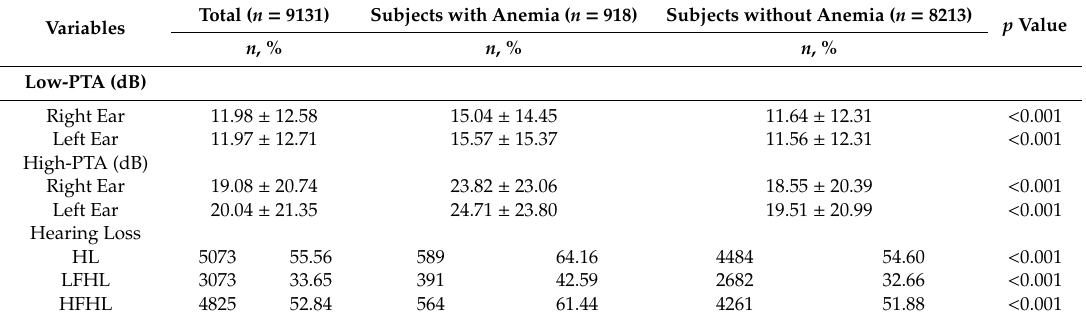
Table 2. High-PTA, low-PTA, and prevalence of hearing loss in subjects with and without